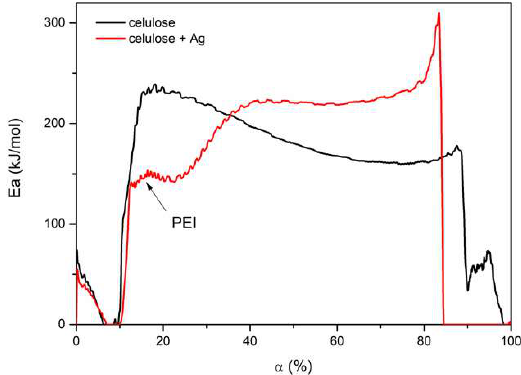
Figure 11. Ea changes as a function of material conversion ( α ).